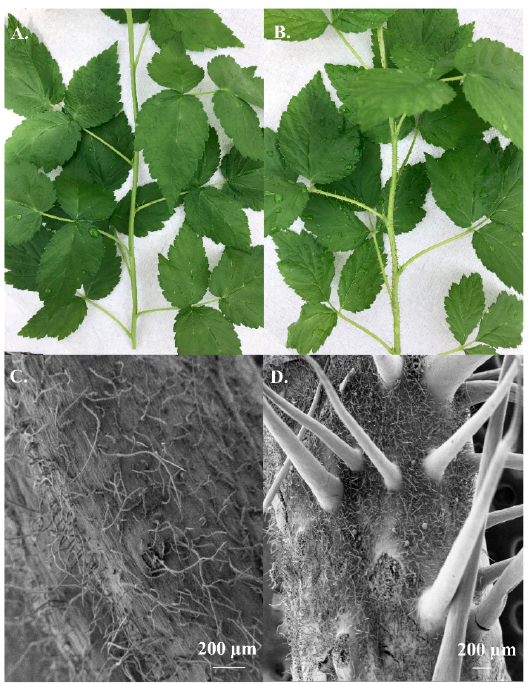
Figure 1. Gross morphology ( A , B ) and micrographs ( C , D ) showing prickles and trichomes on the surface of prickled and prickle-free Rubus idaeus L.: ( A ) prickle-free; ( B ) prickled; ( C ) micrograph of trichomes on prickle-free stem; and ( D ) micrograph of prickles and trichomes on the prickled stem.